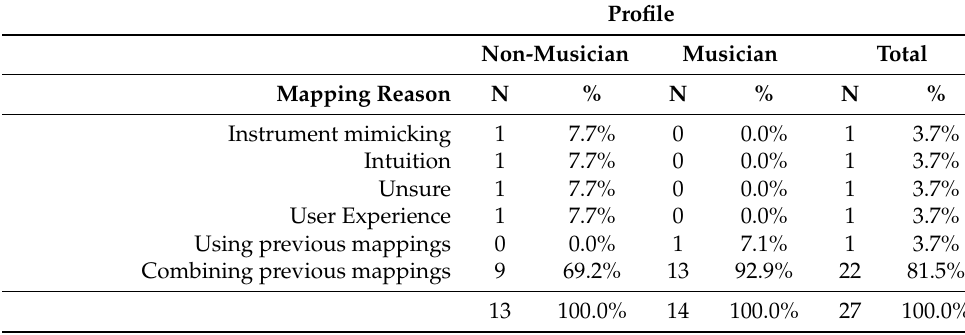
Table A20. Mapping rationale—stimulus d.